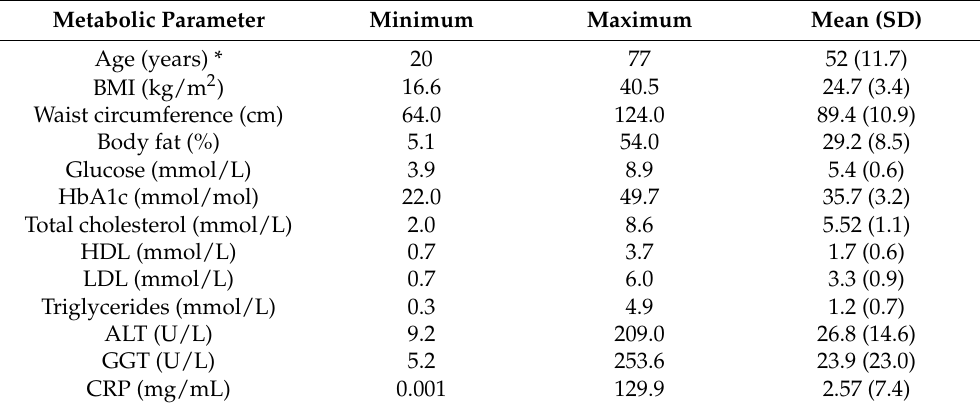
Table 1. General and metabolic characteristics of the individuals selected from the NQplus study ( n =